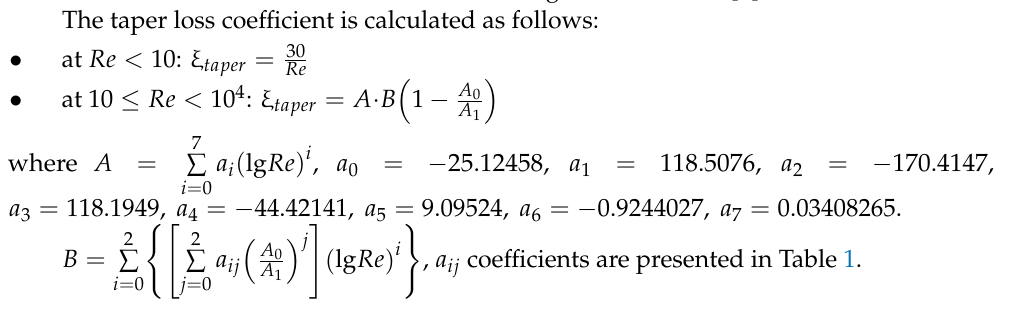
Table 1. Values a ij